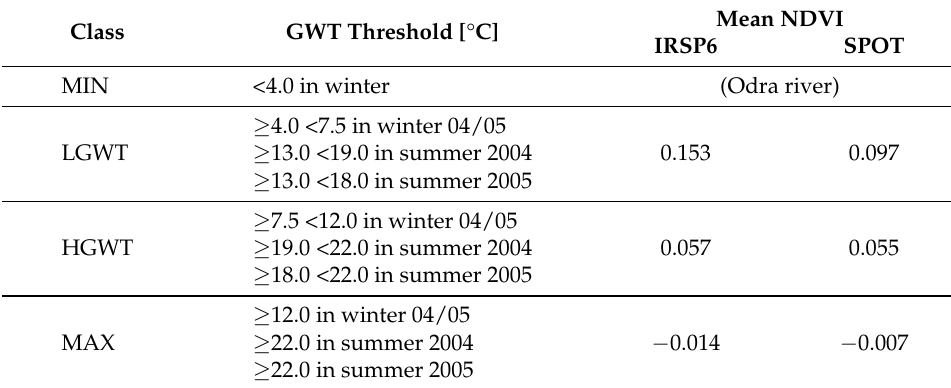
Table 1. NDVI and GWT classification thresholds.